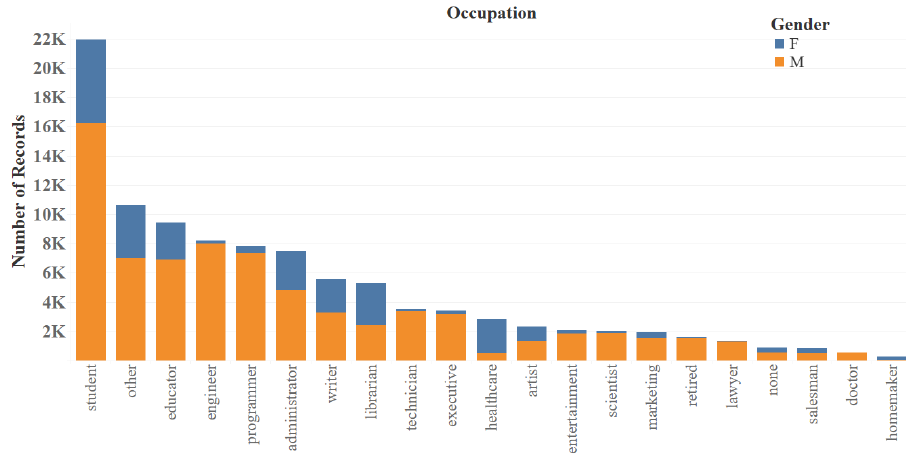
Figure 5. MovieLens occupation